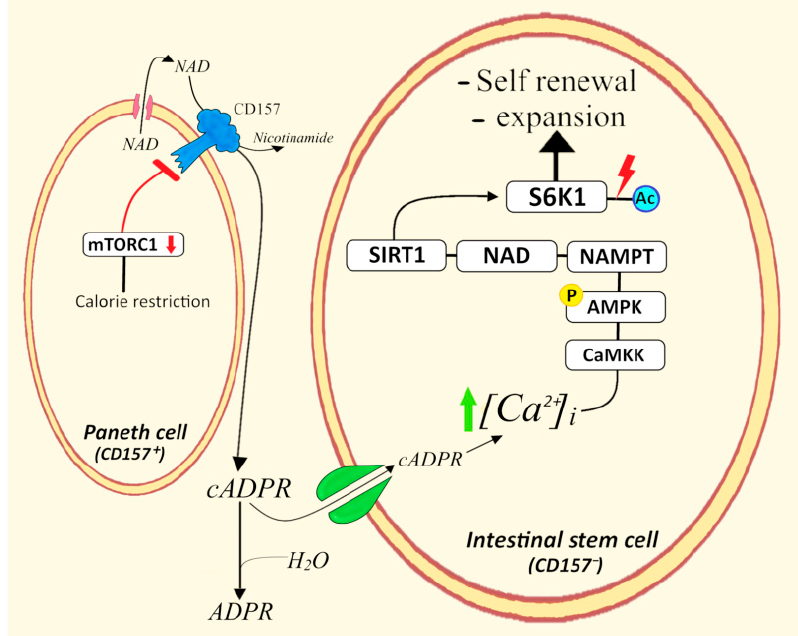
Figure 7. Role of Paneth cells in the Cyclic ADP-ribose-mediated expansion of intestinal stem cells during calorie restriction. mTORC1, mammalian/mechanistic target of rapamycin complex 1; NAMPT, Nicotinamide phosphoribosyltransferase; S6K1, Ribosomal protein S6 kinase 1; CaMKK, Calcium/calmodulin-dependent protein kinase kinase; AMPK, AMP-activated protein kinase; Ac, acetylation; P,